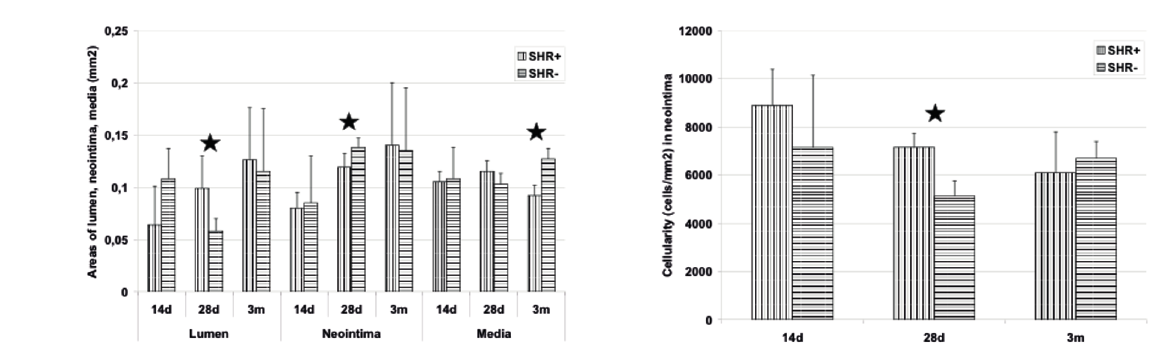
Figure 2. Bar graph demonstrating cellularity in neointima with time after balloon angioplasty in spontaneously hyperten- sive rats with (SHR+) and without ACE inhibitor (SHR-). Asterisk=